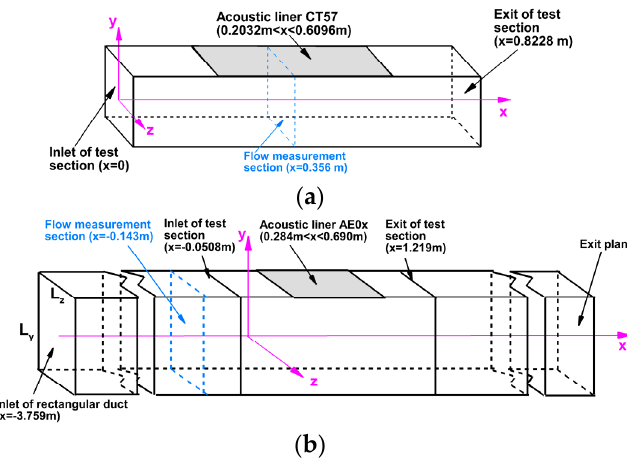
Figure 4. Schematics of NASA GIT [14] test section ( a ) and of NASA GFIT [32] fl ow path ( b ).